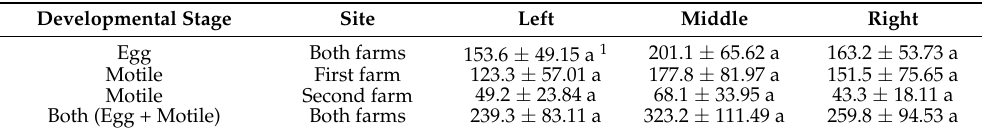
Table 5. Densities (mean ± SE) of T. urticae according to relative locations of leaflets among a trifoliate leaf (density was calculated by summing T. urticae numbers on all leaflets at a location, e.g., left, middle, and right, per